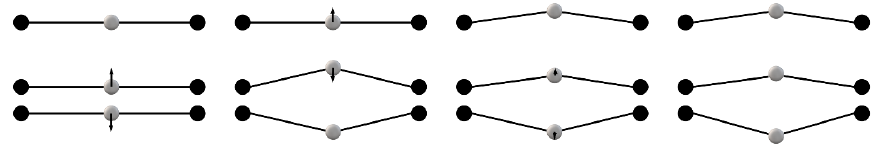
Figure 9. Iterative procedure to solve a conflict in the case of a loss of separation (from left to right ). The flight plans of the two lower UAS are in conflict and need to be separated. Then, the middle UAS enters in conflict with the upper UAS, so these two get separated again. As the plan of the middle UAS gets modified, the lowest UAS is also adapted to achieve a final solution without loss of